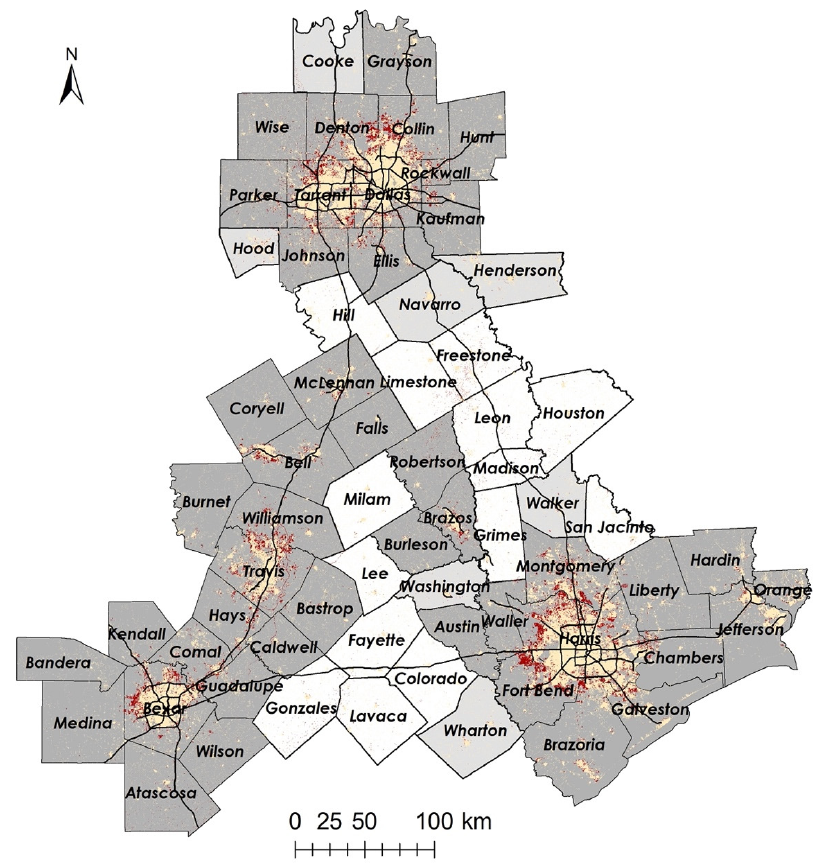
Figure 3. Urbanized Area in the Texas